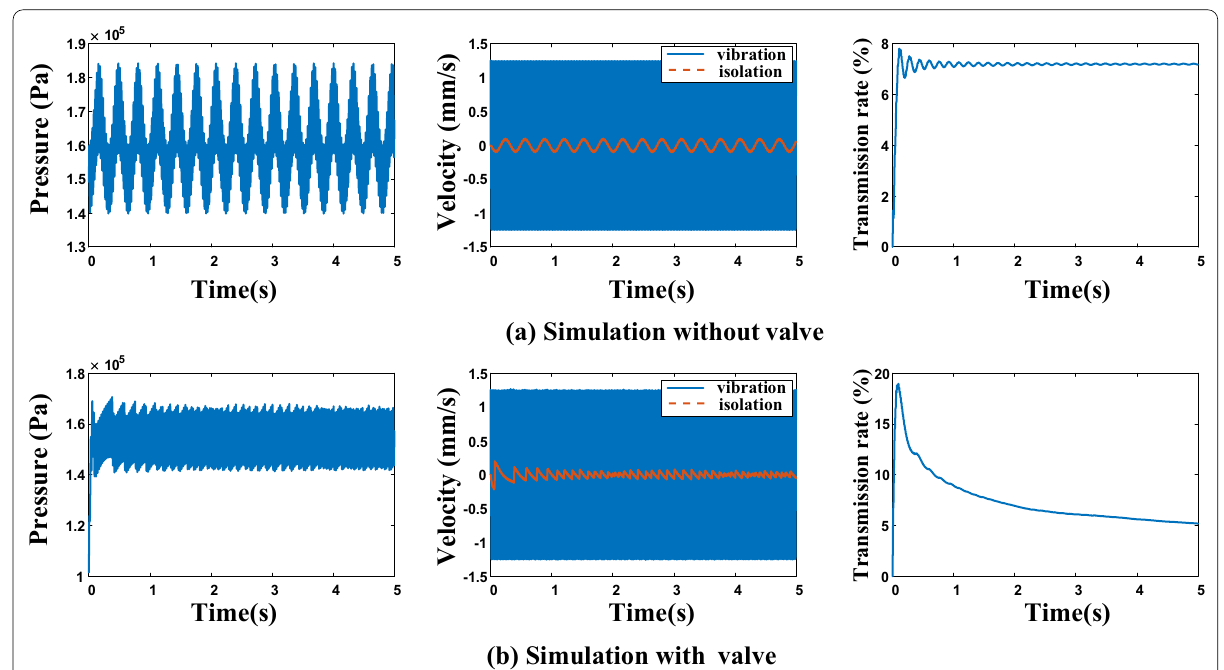
Figure 10 Simulation results comparison of pressure, velocity and transmission rate under 40 Hz vibration